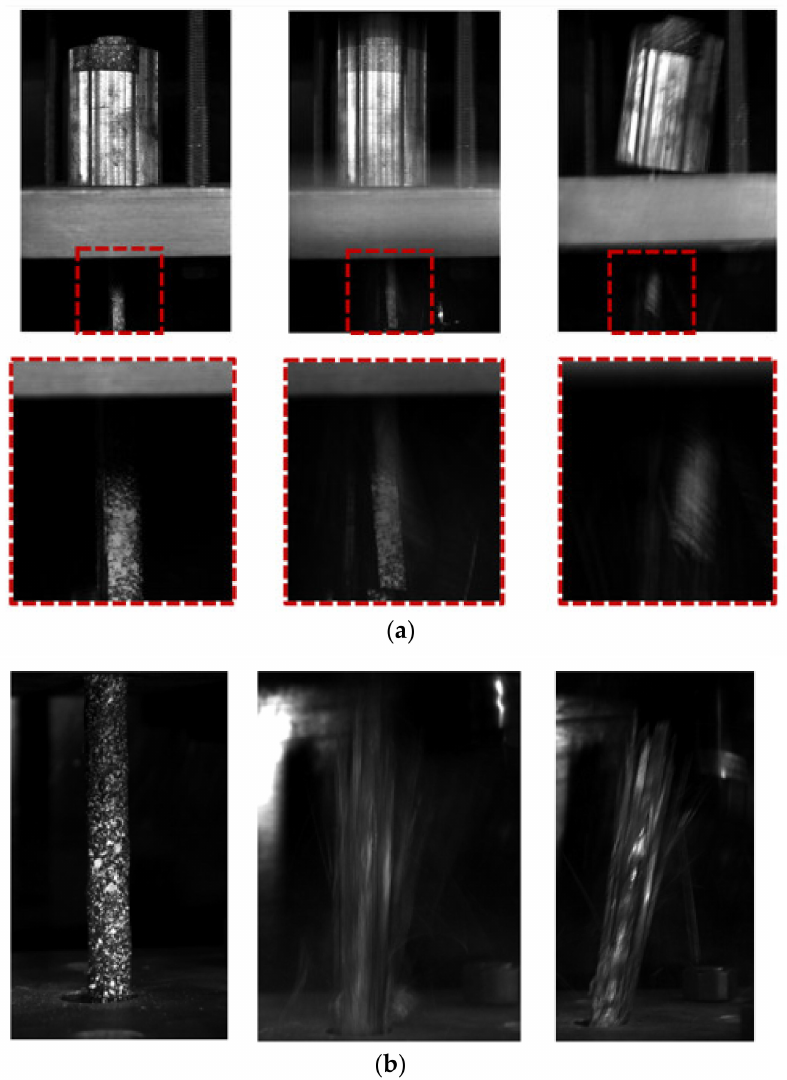
Figure 24. Sequence of frames during the breaking phase: ( a ) SA_Specimen_2–Up: barrel movements; Down: zoom around the breaking zone; ( b )